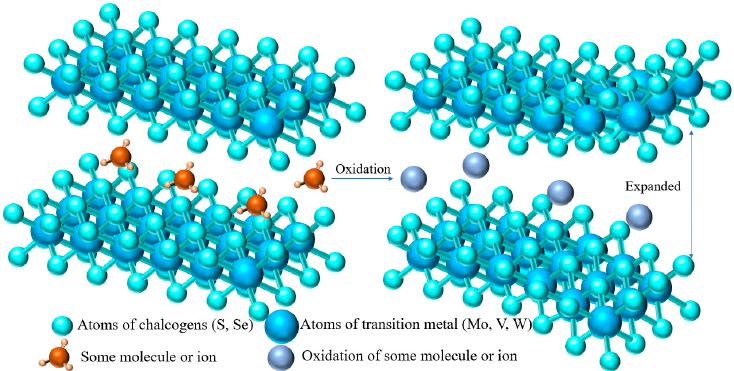
Figure 8. Modification of TMDs by in ‐ situ electrochemical